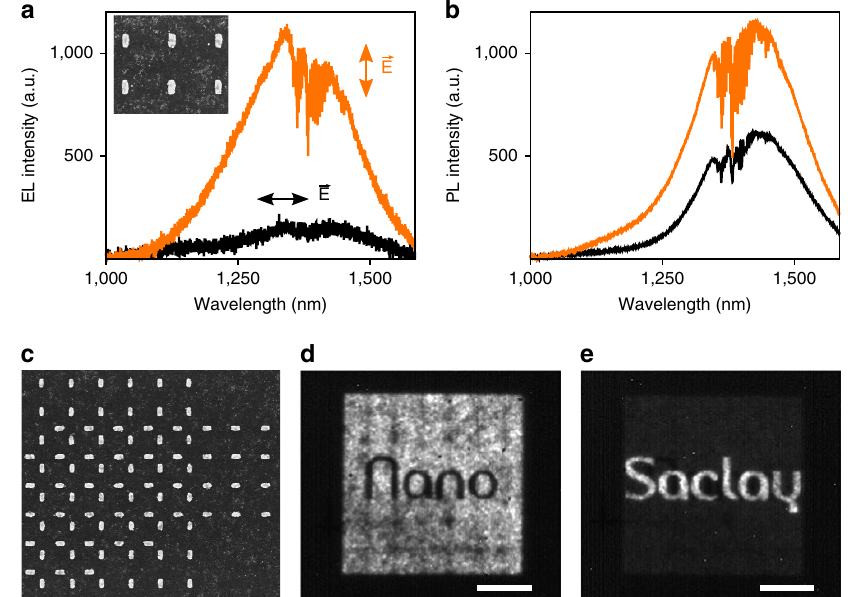
Figure 4 | A true form of artificial EL. ( a ) EL properties of a metamaterial LED operating with an array of gold nanorods with length 150nm, width 70nm and period 500nm. Orange (black) curve: spectrum of the light emitted with a polarization parallel (perpendicular) to the long axis of the nanorods. Inset: SEM view of the array. ( b ) Photoluminescence spectra of the device for the same two orthogonal polarizations. ( c ) A detail of the ‘NanoSaclay’ LED featuring two sets of nanorods with the same dimensions and period as in a and b . ( d , e ) Infrared images of the ‘NanoSaclay’ LED, as seen through a linear polarizer successively aligned with the vertical set of nanorods and the horizontal one. Scale bars, 30 m